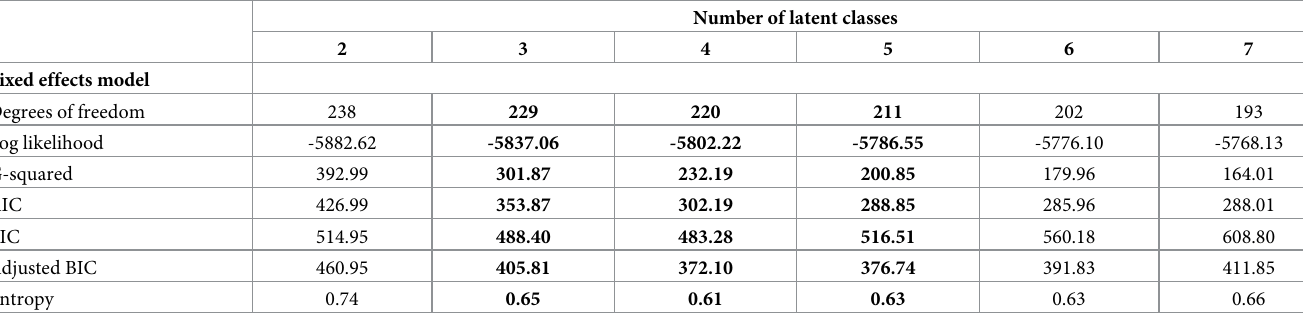
Table 3. Fit statistics for the latent class analysis.